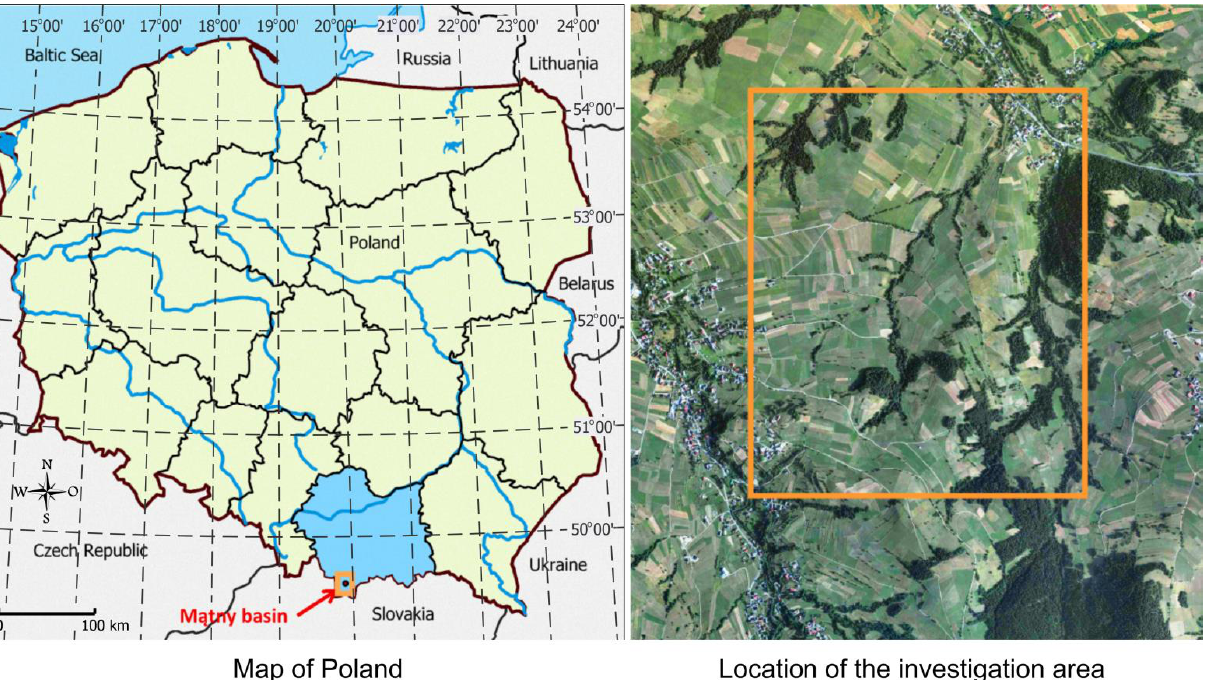
Figure 2. Photos showing typical land use of the Mątny basin. Soils in the catchment area are diverse, depending on slope location. The soil cover in the Mątny stream catchment is dominated by loamy soils, including sandy clay loam, loam, silt loam, clay loam and sandy loam. Pedological conditions were identified by analysis of a 1:25,000 agricultural soil map and categorized into the respective groups according to USDA standards [29].